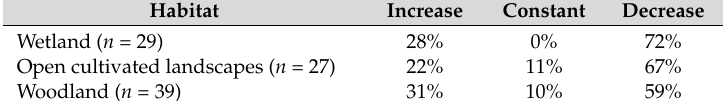
Table 4. Long-term development of breeding bird species depending on their habitat use at Table 4. Long ‐ term development of breeding bird species depending on their habitat use at “Lampertheimer Altrhein” (from 1974–1979 to 2017). “Lampertheimer Altrhein” (from 1974–1979 to 2017).